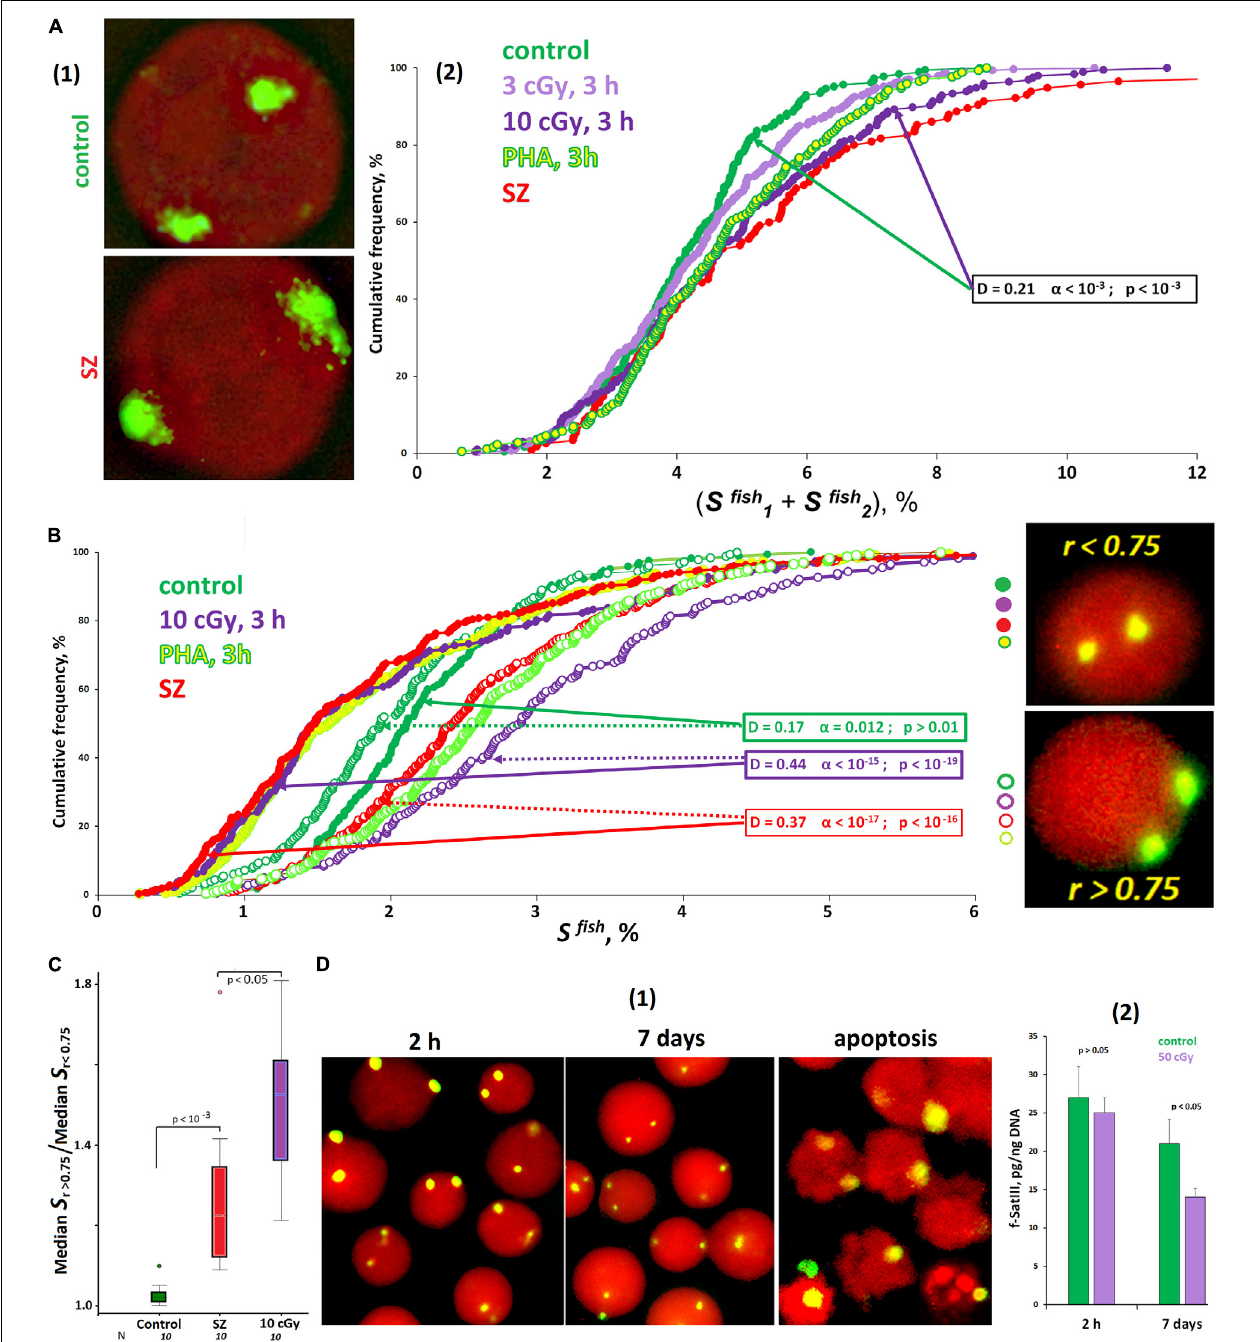
FIGURE 2 | ROS affect the size of f-SatIII repeat in the cells. (A) The area of FISH signals in the nuclei of activated lymphocytes (SZ or IR) is increased. (1) The photo of the control nucleus and the nucleus of the activated SZ cell. (2) Cumulative histograms of the frequency distribution of the FISH signals by the total square S FISH for intact, irradiated (3 and 10 cGy), and PHA-stimulated G0 human lymphocytes and SZ lymphocytes. The signal area increases in about half of the nuclei of the activated cells. (B) Cumulative histograms of the frequency distribution of the FISH signals by the square S FISH for intact, irradiated (10 cGy), PHA-stimulated HC lymphocytes, and SZ lymphocytes. Each sample of FISH-signals was divided into two fractions: signals with r > 0.75 and r < 0.75. The data of comparison of two fractions by the Kolmogorov–Smirnov and Mans–Whitney methods are presented. In the control cells, the two fractions do not differ in the size of the signal areas. In the samples of activated lymphocytes, there is a disproportionation of the cells in terms of f-SatIII repeat areas, depending on r values. (C) The values of the ratio median S FISH ( r > 0.75)/median S FISH ( r < 0.75) for the HC cells, for irradiated HC cells, and for the SZ cells. (D) Prolonged cultivation of irradiated lymphocytes reduces the number of cells with a high f-SatIII repeat content. (1) Photos of the cell nuclei after 2 h and 7 days after irradiation with a dose of 50 cGy. (2) Change in the repeat content in the DNA of irradiated and unirradiated HC lymphocytes during cultivation determined by method NQH. Note: Before the FISH nuclei were treated with RNase